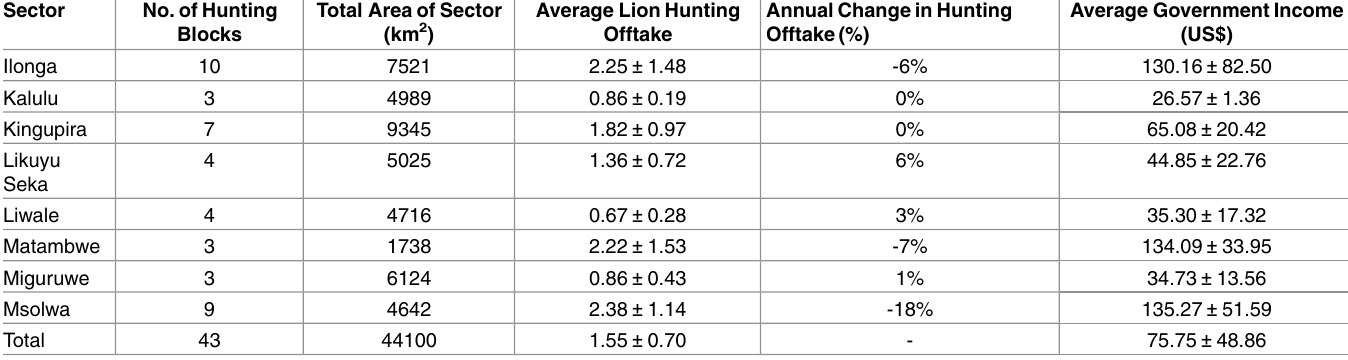
Table 1. Data on lionhuntingofftakeper 1000km 2 , changein huntingofftake,and government incomeper km 2 from withinSelousGame Reserve by sector. Sector No. of Hunting